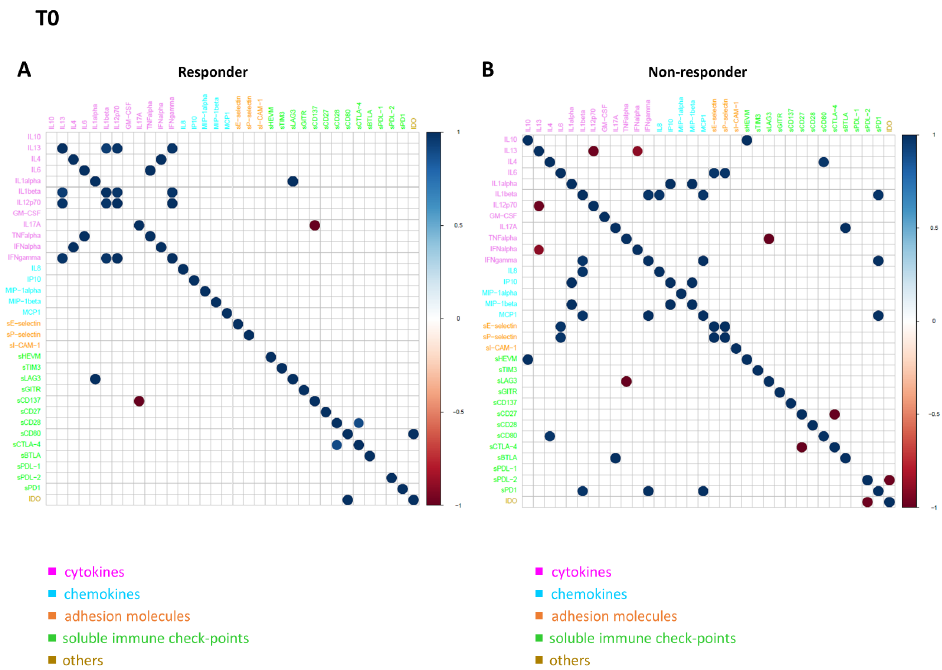
Figure 4. Connectivity map between molecules in responder ( A ) and non-responder ( B ) patients at T0. Statistically significant Spearman correlations ( p -value ≤ 0.05) are reported. In the plot, circles are scaled and colored according to the correlation values, increasing from red (negative correlation) to blue (positive correlation). Molecules are grouped and ordered according to the functional group reported in the legend.